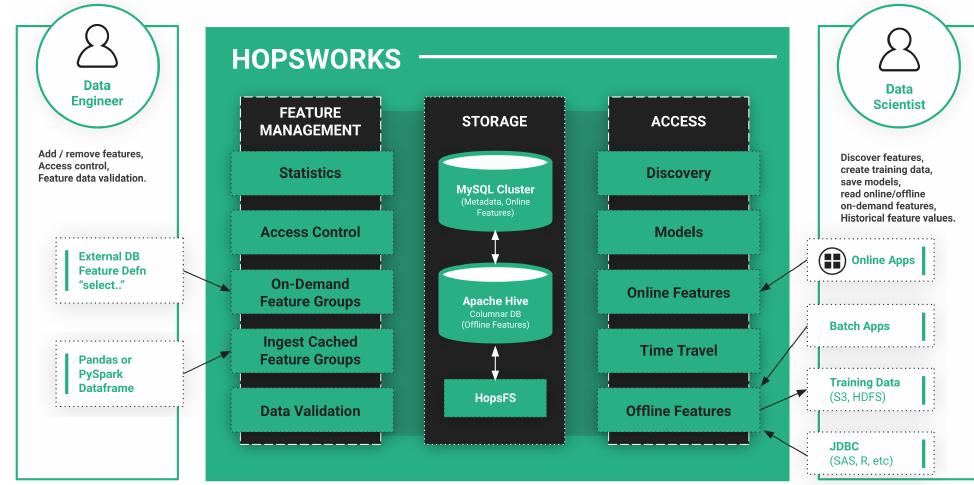
Figure 6. The Hopsworks platform’s Feature Store architecture